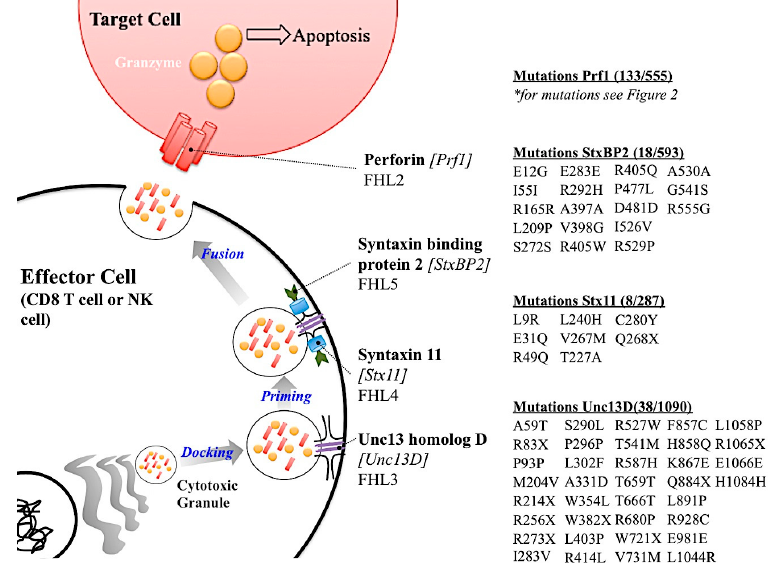
Figure 3. Summary of FHL genetic etiology. A schematic showing the role of the gene causative of FHL subtypes with the listed mutations. Genetic etiology for FHL 1 is not known and is therefore not reported in this Figure. Mutations listed were listed in primary literature. Please use the ExAC Browser database (http://exac.broadinstitute.org/) for more information regarding the mutations in these